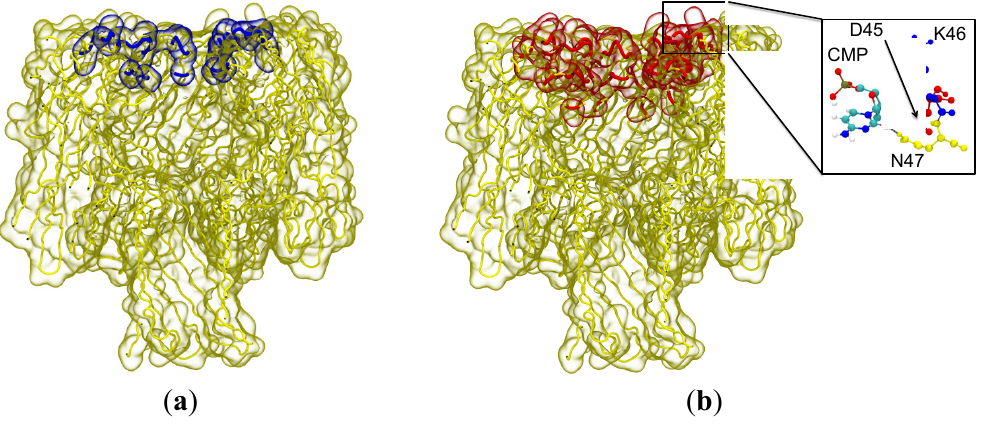
Figure 3. The residues with the highest propensity to interact with the nucleotide for: failed capture ( a ) and possible capture ( b ). The blue highlighted residues corresponding to failed capture are on the edge of the vestibule entrance and on the surface of the vestibule. The red highlighted residues associated with possible capture are predominantly on the edge of the entrance to the vestibule. ( Inset ) The most frequently observed binding mode between cytosine monophosphate (CMP) and the amino acid triplet, D45, K46 and N47. Hydrogen bonds (dashed lines) are observed between the hydroxyl group of the sugar and the side-chain of D45, as well as the nucleobase and the side-chain of N47. These hydrogen bonds are stable and are present for extended periods of time (greater than 1 ns). Residues are coloured for clarity; D45 in red K46 in blue, and N47 in